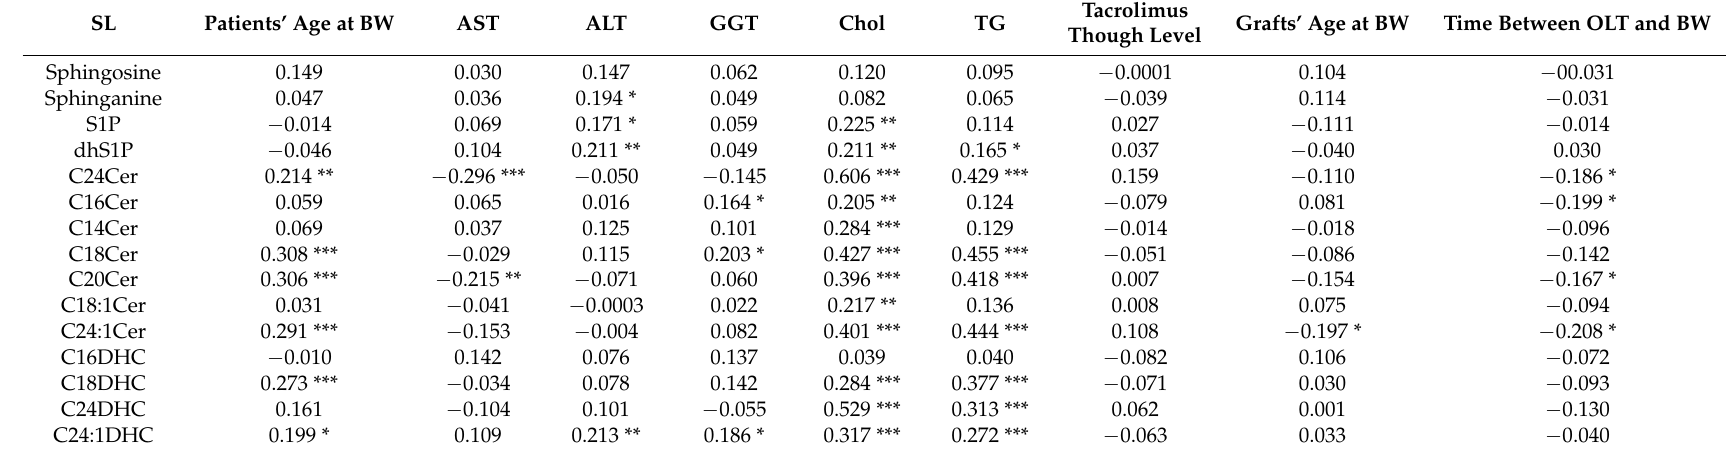
Table 2. Correlations of serum SL’s of patients post-OLT with age of patients and grafts, biochemical parameters and time between OLT and inclusion.